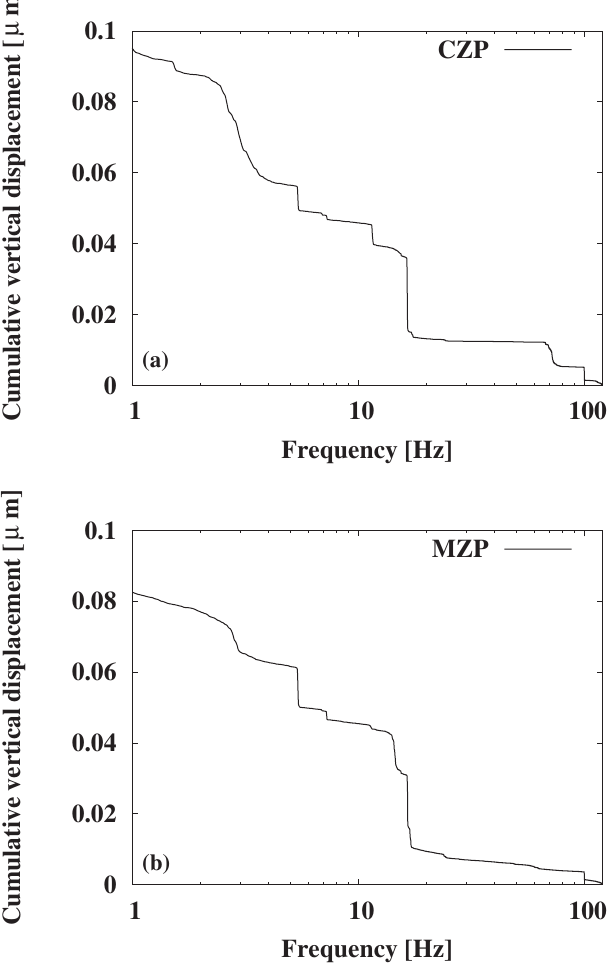
FIG. 14. Cumulative vertical displacements of (a) CZP and (b)